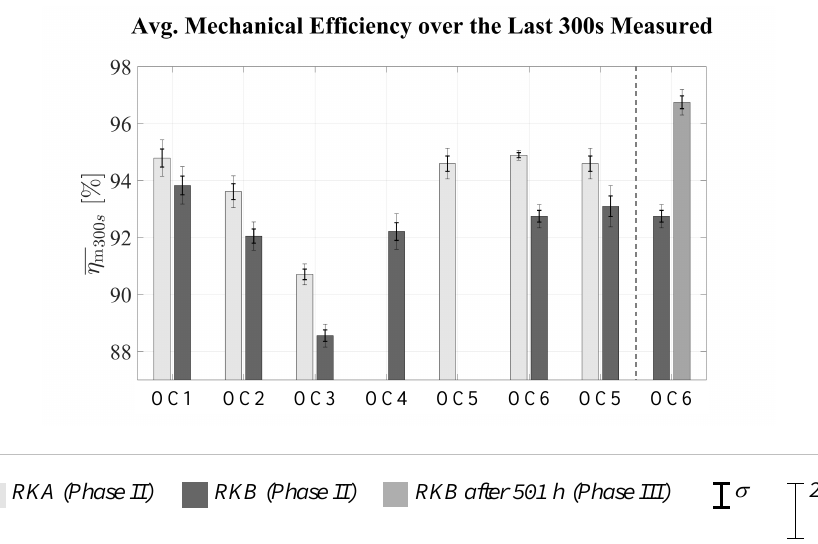
Figure A3. Average mechanical efficiency over the last 5 min